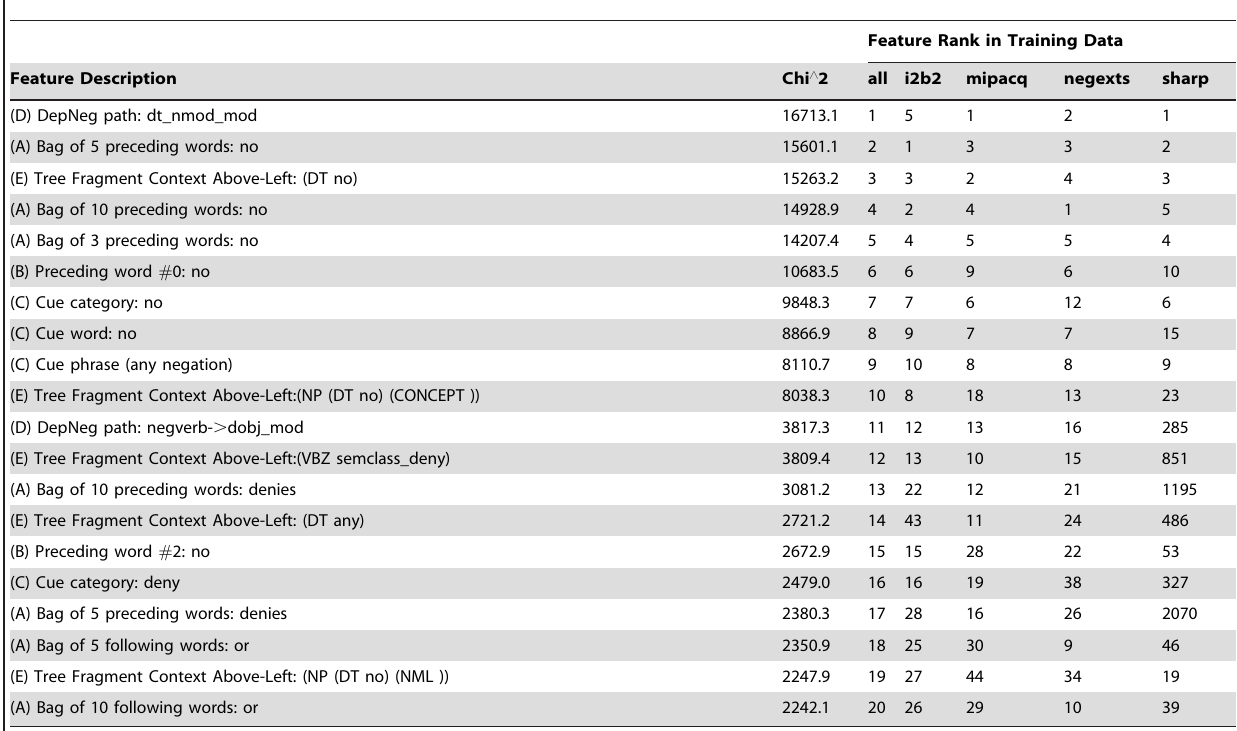
Table 6. Top negation context features in a multi-corpus model, by chi-square value; and feature rank in domain-specific